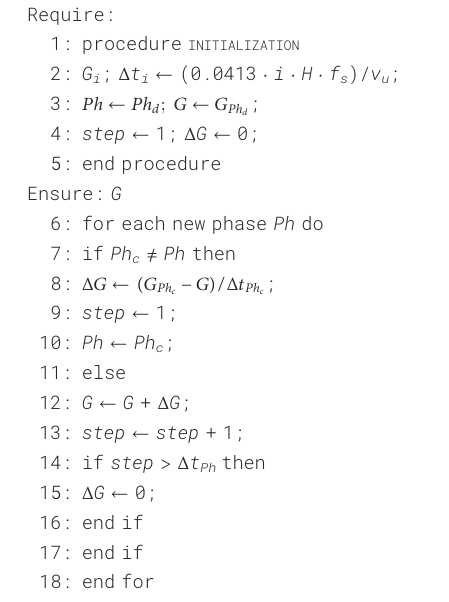
Algorithm 2. Online Gait Pattern Modulation